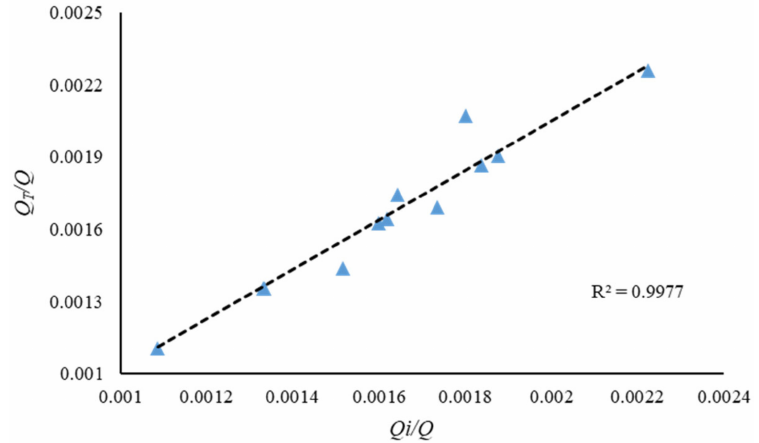
Figure 8. Calculated ice transport capacities compared to those measured from